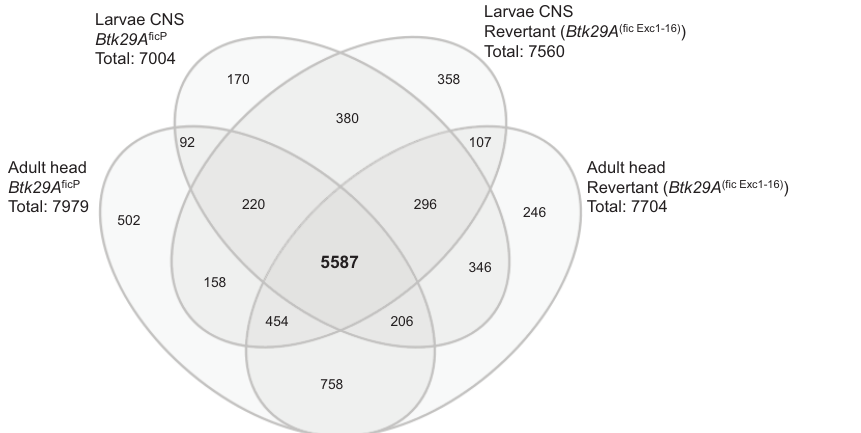
Figure 7. Distribution of expressed transcripts in each sample group and their overlaps: Venn- diagram showing the number of expressed probe-sets of the respective sample group and their overlap. The probe-sets found to be expressed above background (Affymetrix P-calls) in all three replicates per sample group were considered within this figure.